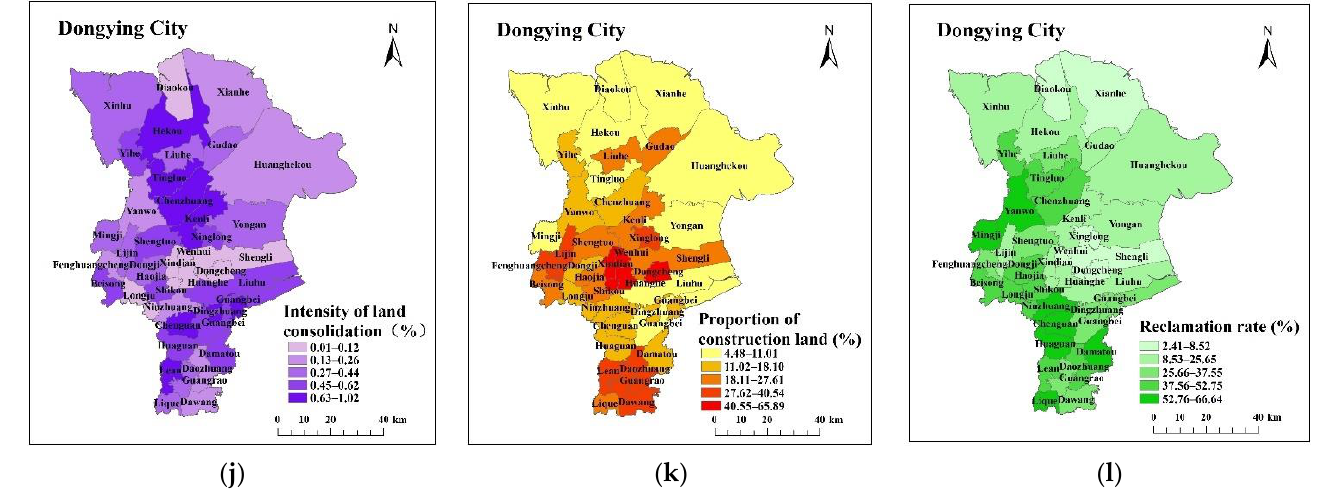
Figure 2. Spatial distribution of each index: ( a ) The proportion of river area; ( b ) Terrain relief; ( c ) Forest Vegetation Coverage; ( d ) Road network density; ( e ) Distance from county center; ( f ) Population density; ( g ) GDP per capita; ( h ) Arable land area per capita; ( i ) Construction land area per capita; ( j ) Intensity of land consolidation ( k ) Proportion of construction land; ( l ) Reclamation rate. Natural attributes mainly include terrain relief, forest vegetation coverage and the proportion of river area. The topographic relief reflects the topography, elevation and al- titude of each township, affects the distribution trend and land-use pattern of cultivated land, residential sites, and construction land, and also determines the difficulty of land